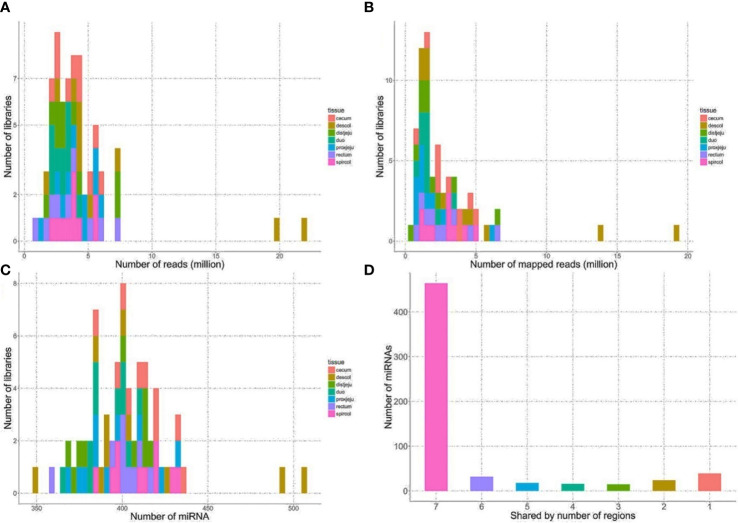
General sequencing results and miRNA mapping results. (A) Distribution of numbers of reads generated from HiSeq 2000 sequencing platform. (B) Distribution of numbers of reads mapped to known bovine miRNA after quality filtering. (C) Distribution of numbers of detected miRNA from the intestinal regions. (D) Number of miRNA shared by the intestinal regions, the number on x-axis represents the number of intestinal regions a miRNA is shared by, seven, all intestinal regions; six, six out of seven regions, five, five out of 7 regions, four, four out of seven regions; three, three out of seven regions; two, 2 out of seven regions; one, only detected in one of 7 regions.